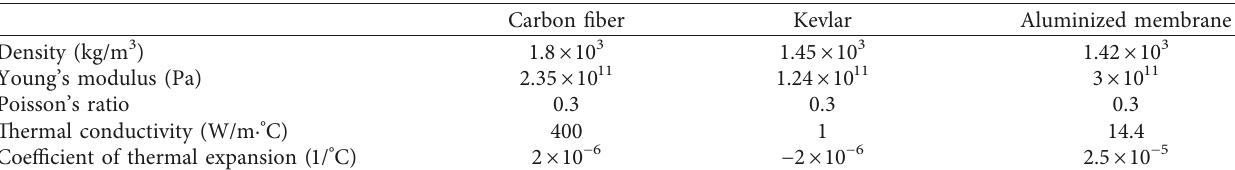
Table 4: Properties of related materials.